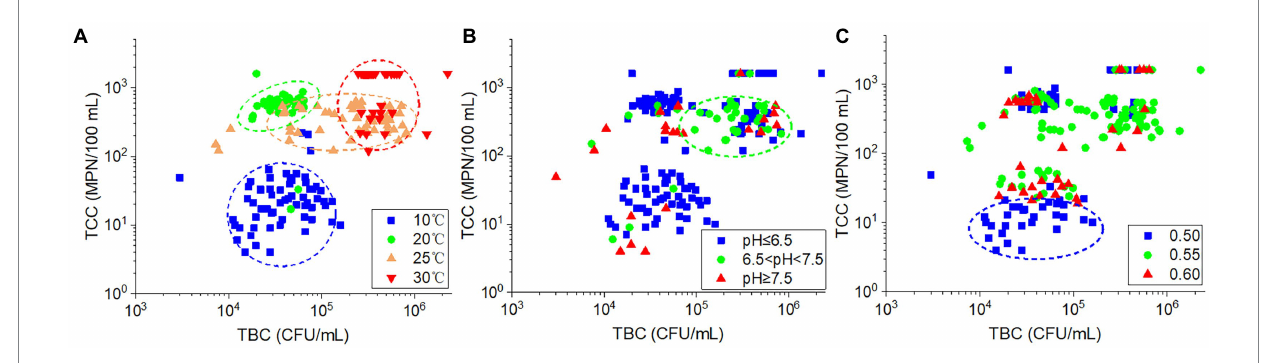
Figure 7B, the samples with low-pH values (pH ≤ 6.5) and high-pH values (pH ≥ 7.5) were dispersed, whereas the majority of samples with intermediate pH values (6.5 < pH < 7.5) were concentrated in an area of higher TCC and TBC. With regard to porosity (Figure 7C), samples with lower TCC value (in the cycle of the plot) were mostly found in soils with 0.5 porosity. The remaining samples were dispersed throughout the plot, indicating a lack of clear relationship between porosity and TBC or TCC in these samples. As a result, the variation of TBC and TCC in the samples appears to be influenced by temperature, pH, and porosity in a similar but also somewhat diverse